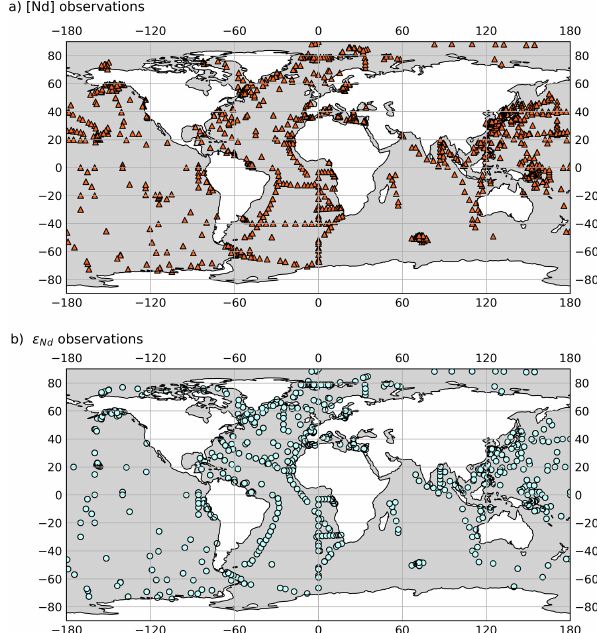
Figure 8. Location of marine observational records used in this study: (a) filled orange triangles show the location of dissolved Nd concentration records, while (b) filled sky-blue circles show the lo- cation of dissolved ε Nd